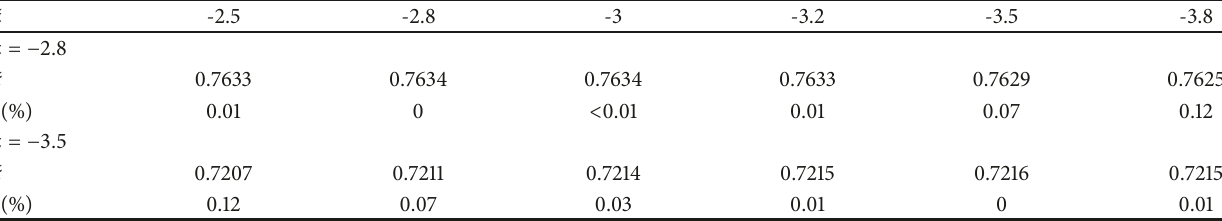
Table 2: The robustness of revenue for estimation of network